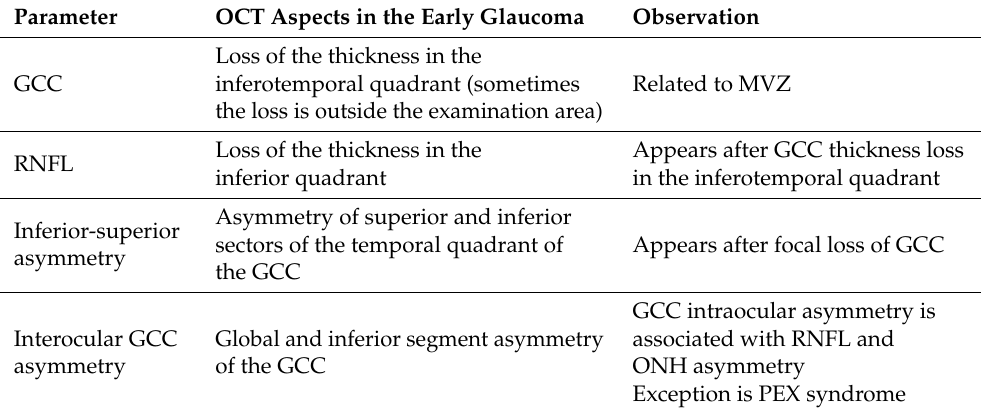
Table 2. Summary of the OCT criteria for early-stage glaucoma